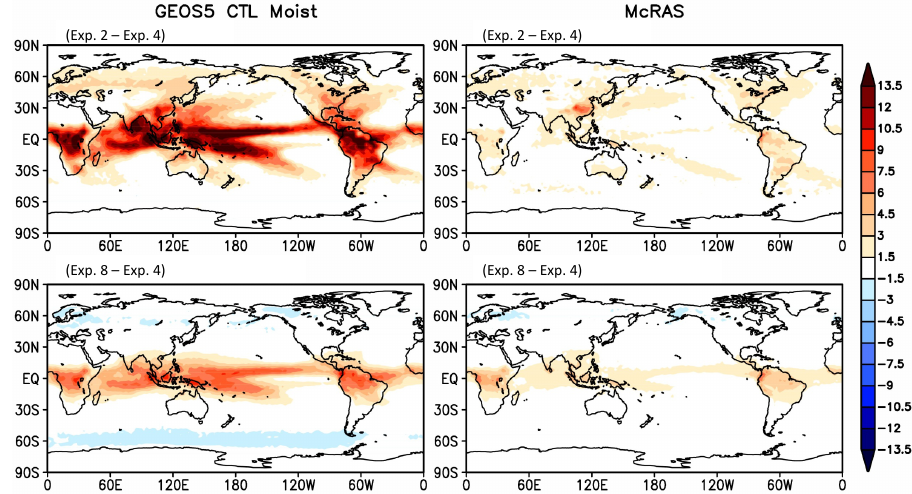
Fig. 5. Maps of annually averaged CRE SW differences between the Exp. 2 and Exp. 4 (top) and between Exp. 8 and Exp. 4 (bottom). The left panels are for the CTL cloud scheme, while the right panels are for